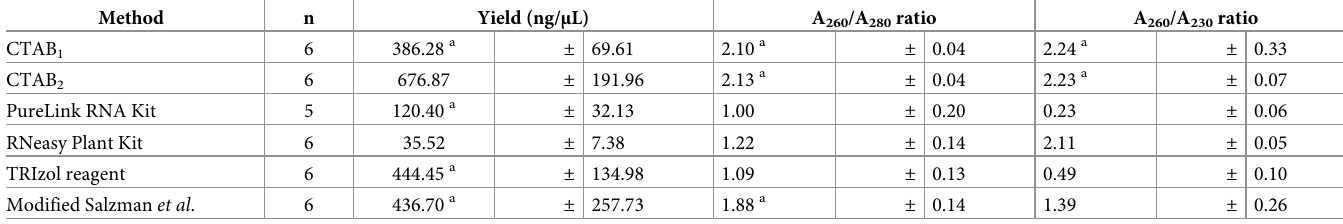
The values correspond to the mean of the values and MAD (mean absolute deviation) obtained between the replicates (n) of each method in two independent experiments. Values within rows followed by the same letter are not significantly different, using One-way ANOVA followed by Dunnett’s test, p < 0.05 when compared with CTAB 2